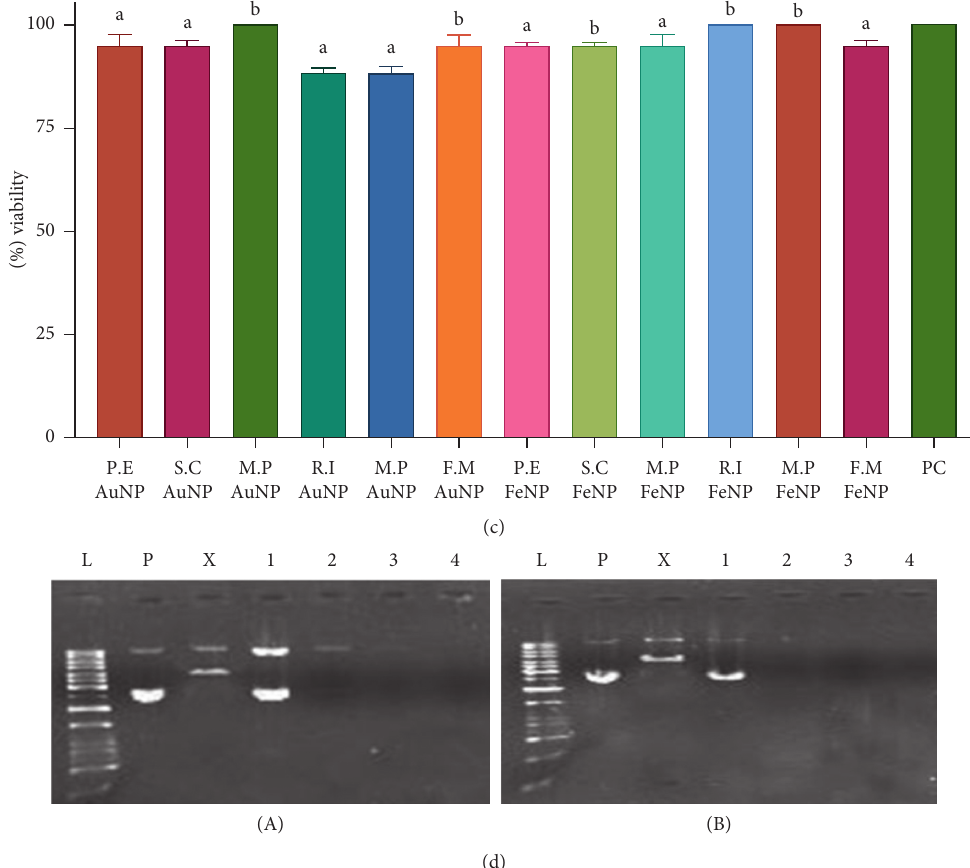
Figure 3: (a) Minimum inhibitory concentration of gold and iron nanoparticles against bacterial strains; S.A Staphylococcus aureus , M.L Micrococcus luteus , B. sub Bacillus subtilis , B. sep Bacillus septica , E. coli Escherichia coli , E.A Enterobacter aerogenes , S.T Staphylococcus aureus . (b) IC50 values of antioxidant potential of gold iron nanoparticles (FeNPs and AuNPs) assessed by DPPH free radical scavenging assay. (c) Brine shrimp cytotoxic assay, percent viability of brine shrimps at 50 μ g/mL dose of gold and iron nanoparticles (FeNPs and AuNPs). (d) (A) DNA damage assay of gold nanoparticles (AuNPs), (B) DNA damage assay of iron nanoparticles (FeNPs); L: DNA